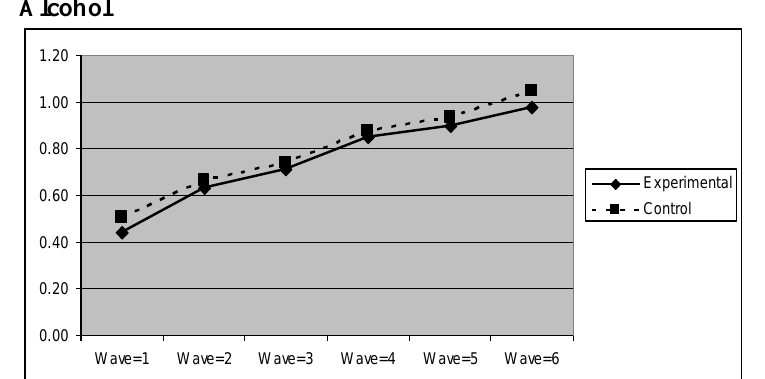
FIGURE 10 . Growth trajectories of the experimental group (Tier 1 participants who perceived the program as effective) and control group using the item score of smoking as the outcome indicator.